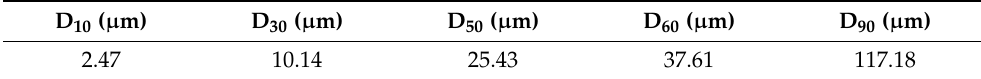
Figure 2. Particle size distribution (PSD) of the tailings used in the study. Table 2. PSD data of tailings.